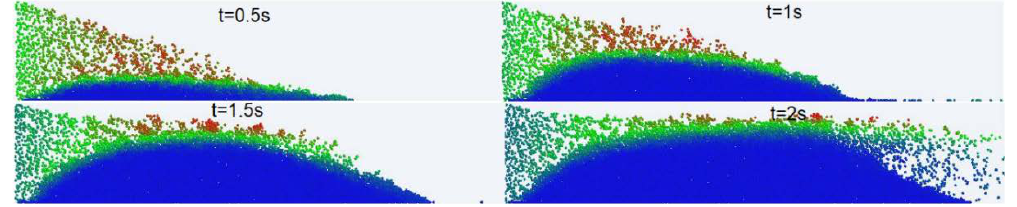
Figure 10. Distribution of proppants along with fracture slot of the vertical well.